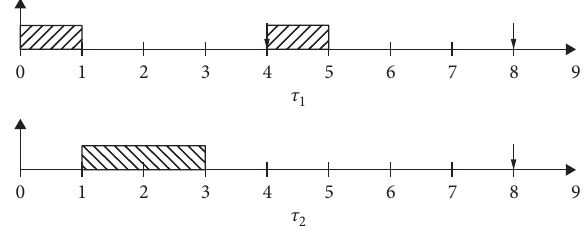
Figure 2: Task τ